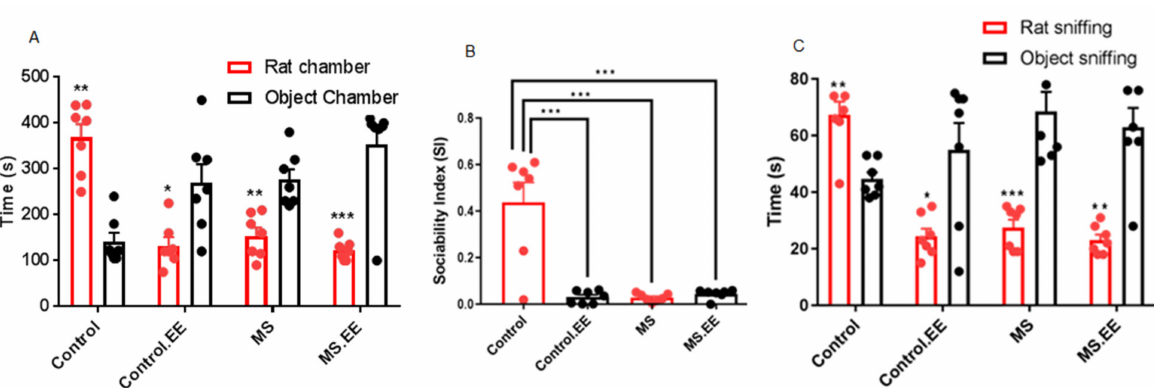
Figure 2. Effects of maternal separation and EE on social behavior ( A ), sociability index ( B ) and direct social interaction ( C ). * p < 0.05, ** p < 0.01, *** p < 0.001. N = 10 in each group. MS: Maternal Separation, EE: Environmental